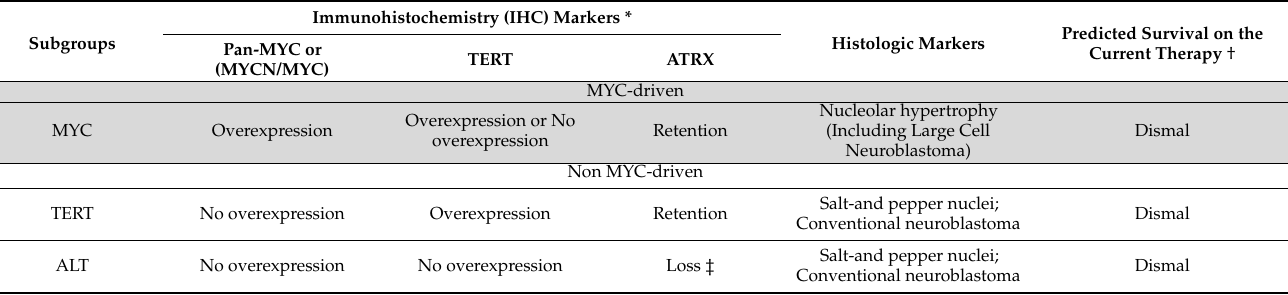
Table 2. Proposed subgroups of unfavorable histology